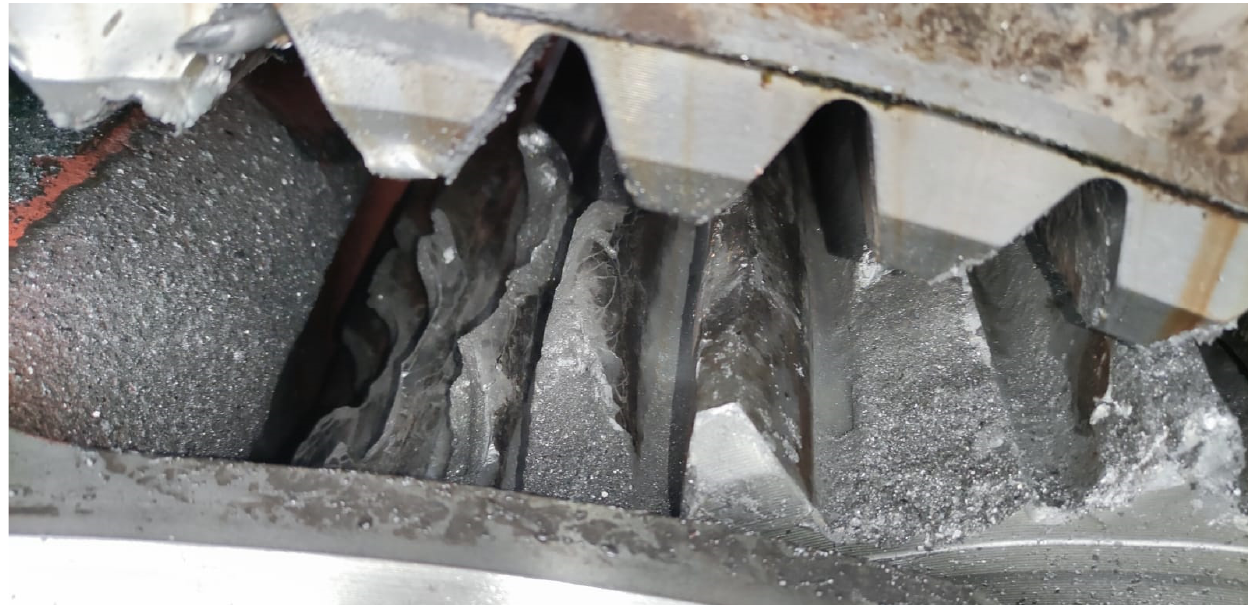
Figure 11. Total break-off of toothed wheel fragments in the wind turbine planetary gear.